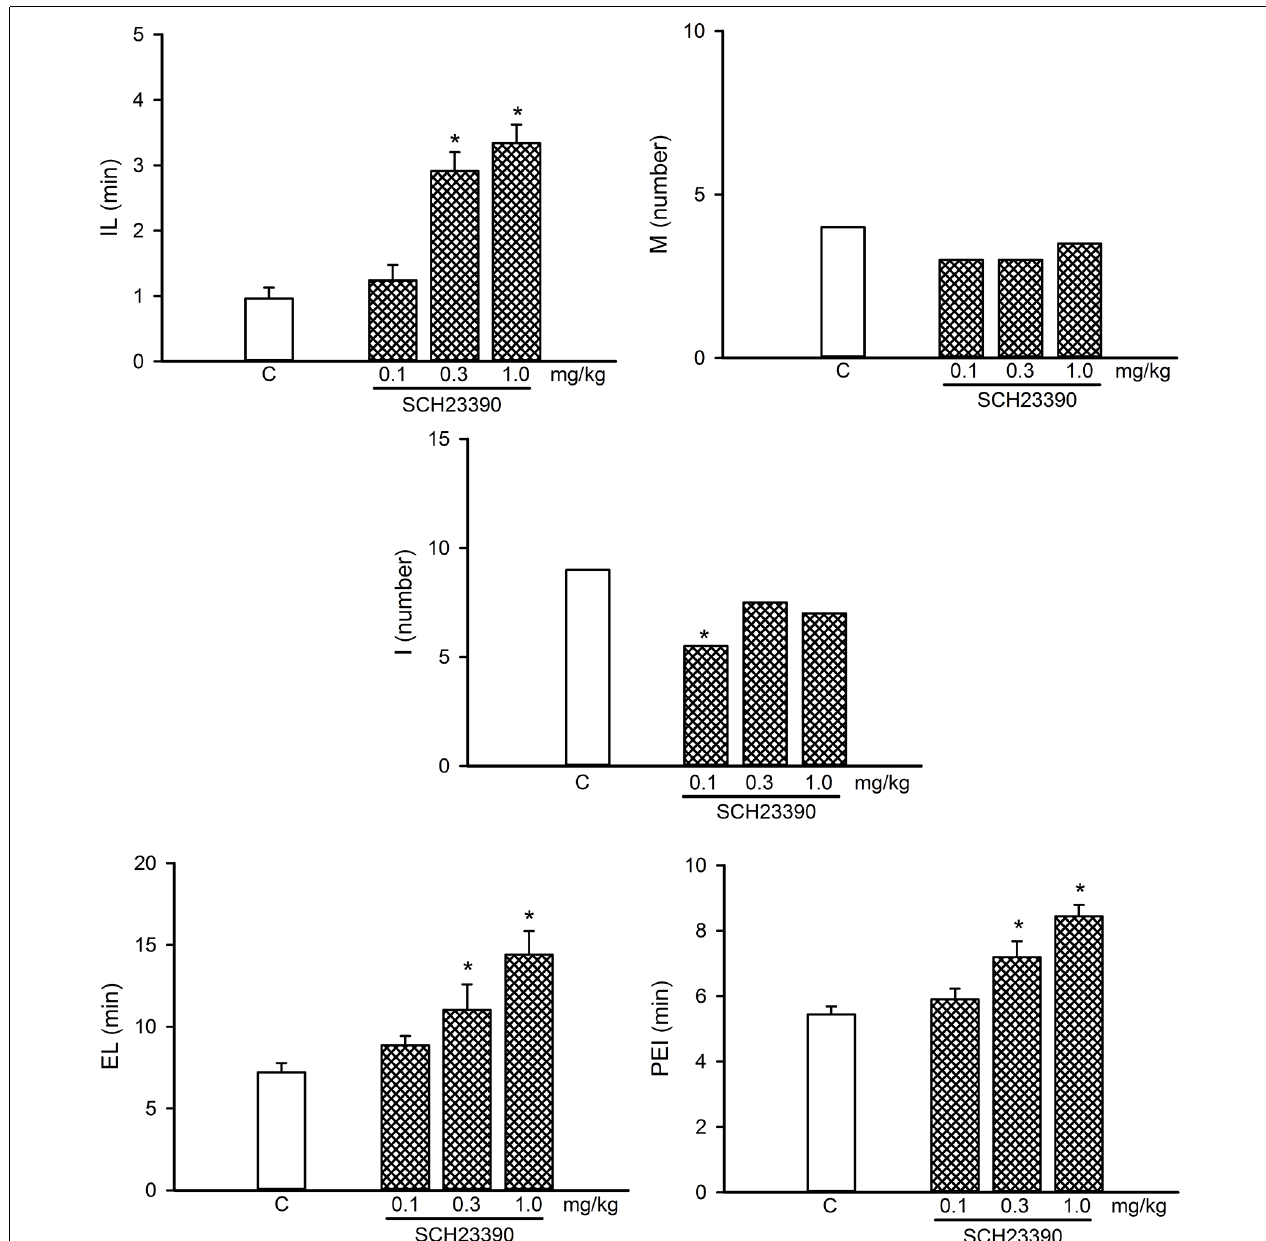
FIGURE 6 | Dose-response curve of the effects of different doses of the D1-like receptor antagonist, SCH23390 (0.1–1.0 mg/kg, n = 8 each), on sexual behavior of sexually experienced male rats. IL, intromission latency; M, number of mounts; I, number of intromissions; EL, ejaculation latency; PEI, postejaculatory interval; C, control. Latencies are expressed in minutes, as mean ± SEM, and numbers as medians. Kruskal–Wallis ANOVA followed by Dunn’s test, ∗ P < 0.05 vs.